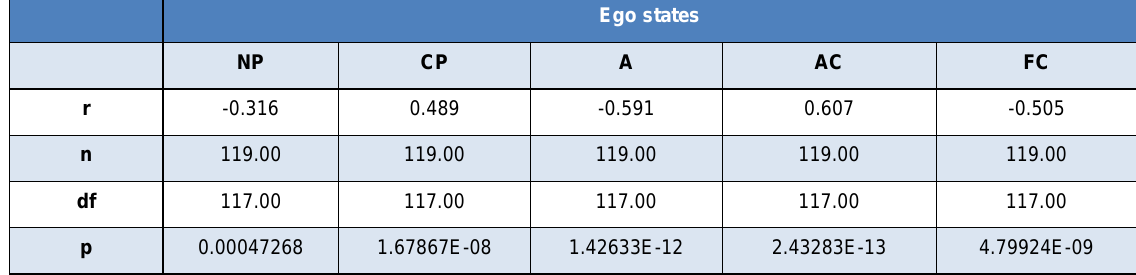
Table 8: Significance testing of r: Ego states and Neuroticism (25-40 yrs of age)